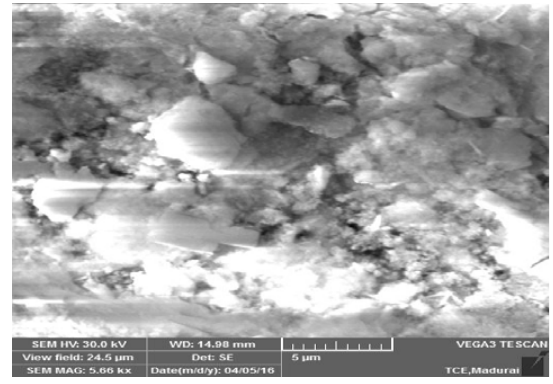
Fig. 3. SEM image of ZnO-SiO